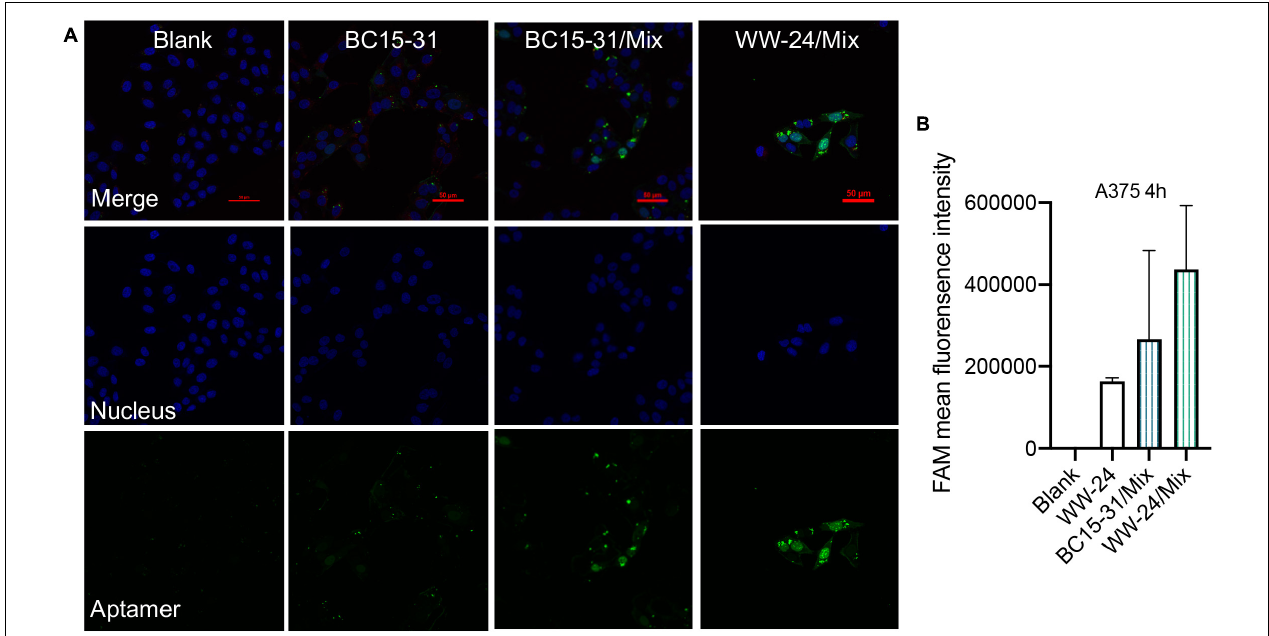
FIGURE 4 | Liposomes improve transmembrane ability of aptamers. (A) Confocal analysis of lipid/aptamer nanocomplex permeation (FAM-aptamers, 25 nM). The cells were observed at 6 h after incubation with blank, FAM-BC15-31, FAM-BC15-31/Mix, and FAM-WW-24/Mix nanocomplexes, in which the aptamer and nucleus were visible by green and blue colors. (B) Cellular uptake of lipid/aptamer nanocomplex permeation (FAM-aptamers, 25 nM, n = 3) at 4 h. All data in this study are average values, and error bars represent standard